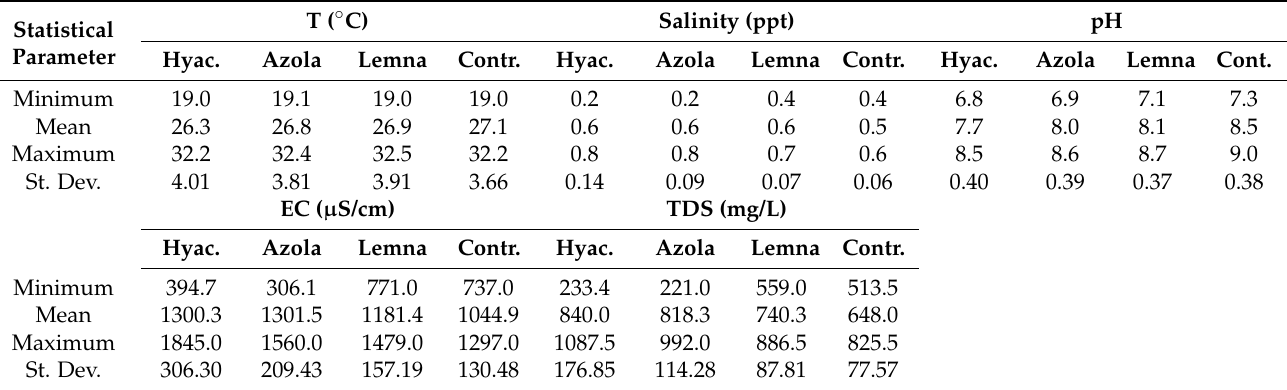
Table 3. Physicochemical parameters in the test system